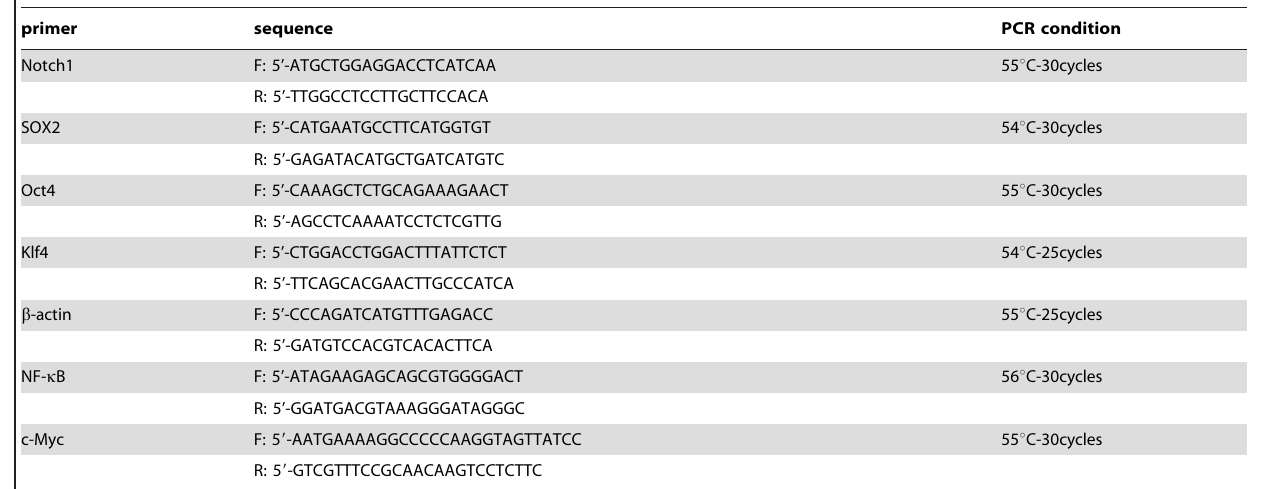
Table 1. Primers used in this study.